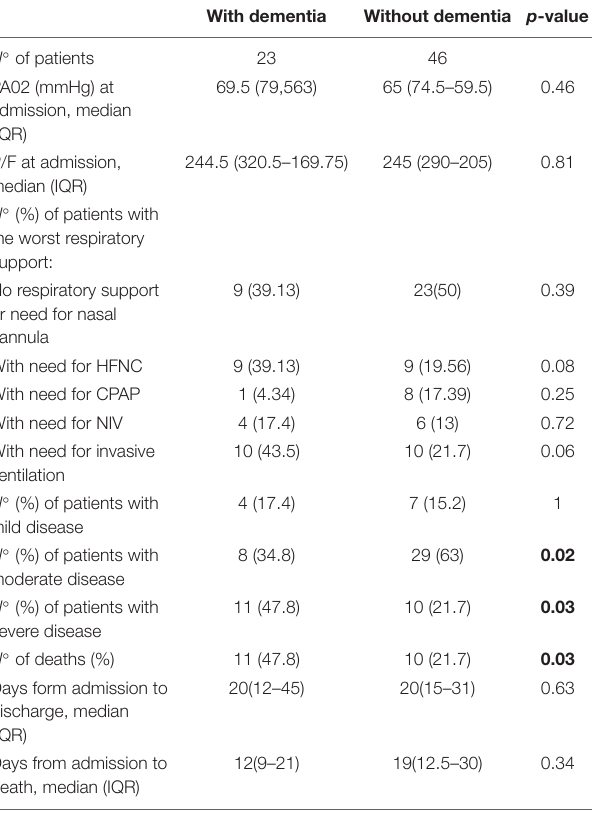
TABLE 2 | Demographic and clinical characteristics of the patients according to the presence or absence of dementia. With dementia Without dementia p -value